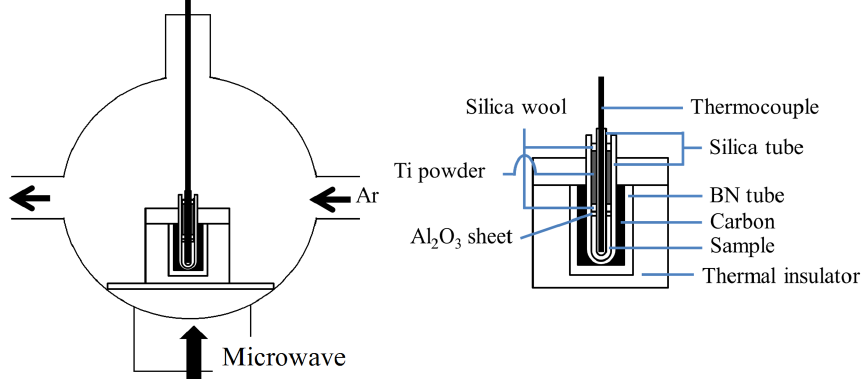
Figure 6. Experimental set up for microwave irradiation.